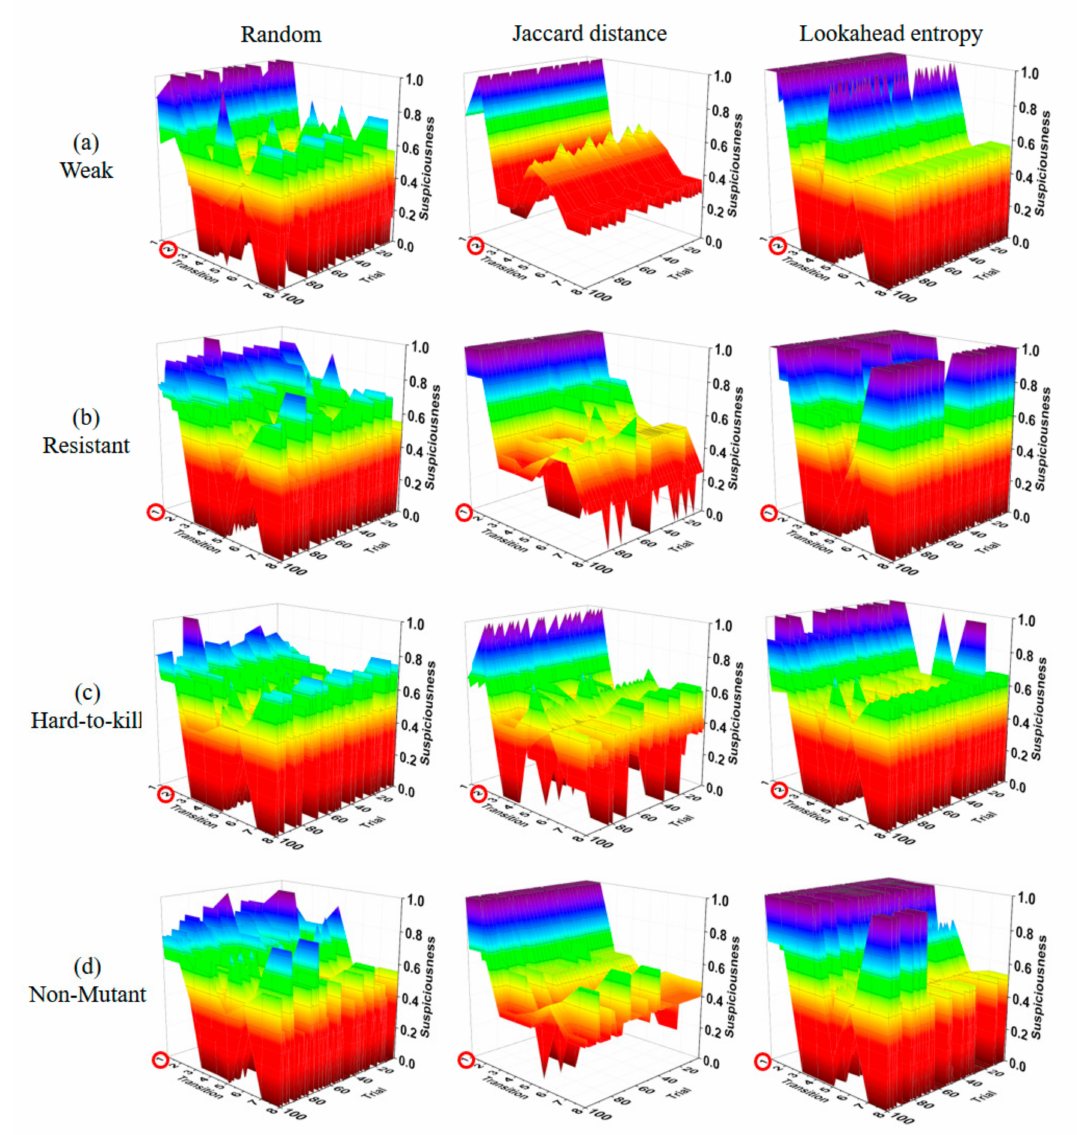
Figure 13. Suspiciousness of the whole transition (star state